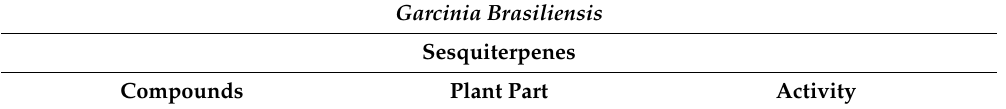
Table 1. Compounds present in di ff erent parts of Garcinia brasiliensis and their related